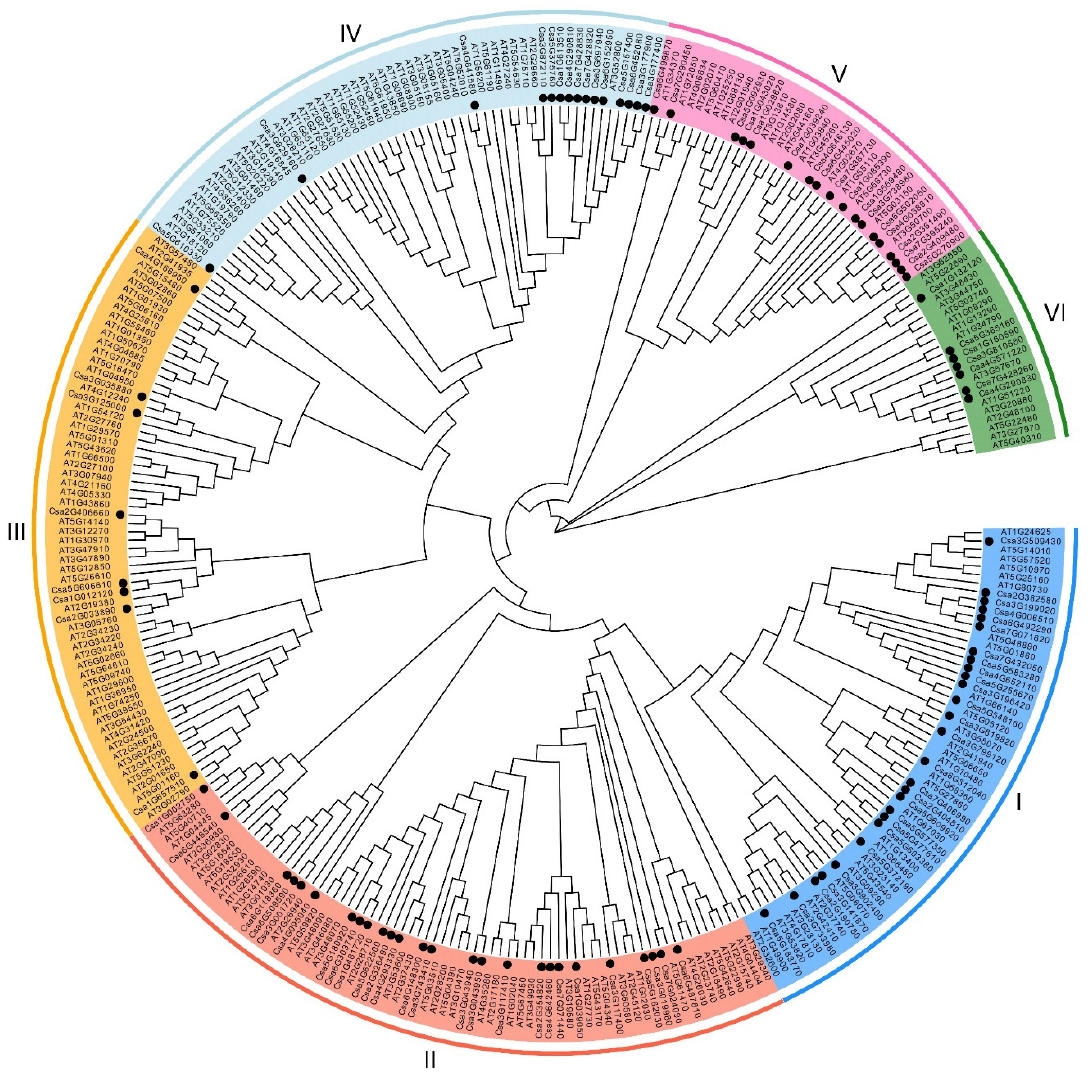
Figure 2. Phylogenetic analysis of C2H2-ZFPs in Arabidopsis and cucumber. The phylogenetic tree was based on C2H2-ZFP sequences from cucumber (101 proteins, marked with a black dot) and Arabidopsis (208 proteins). Each of the six C2H2-ZFP groups is indicated in a specific color.